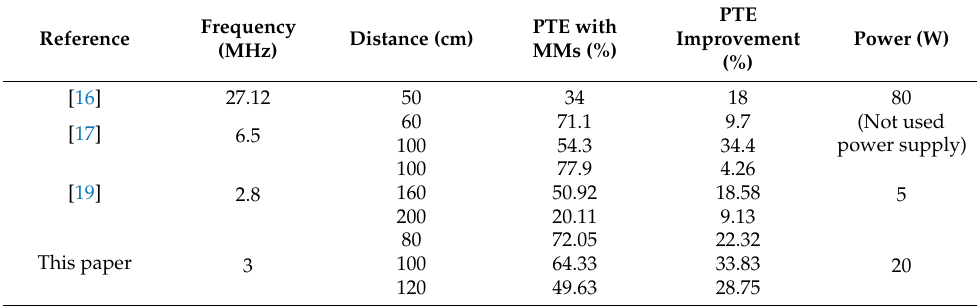
Table 3. MM-based WPT system performance